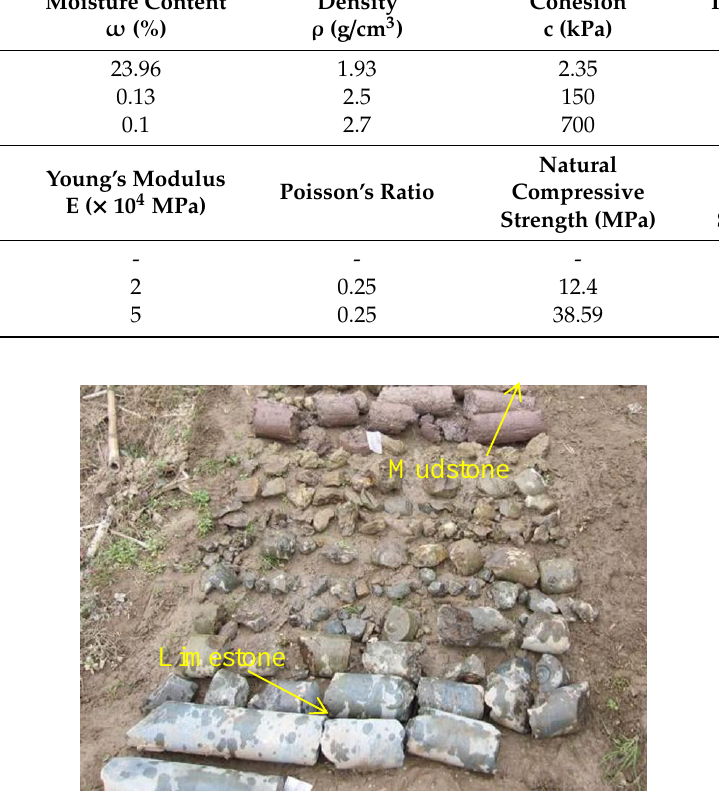
Figure 4. Core samples of mudstone and limestone in site investigation area (H).